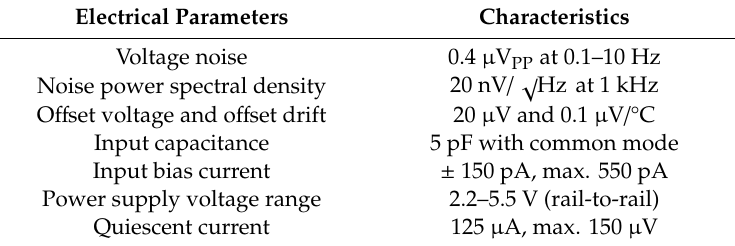
Table 1. Electrical characteristics of the OPA378 operational